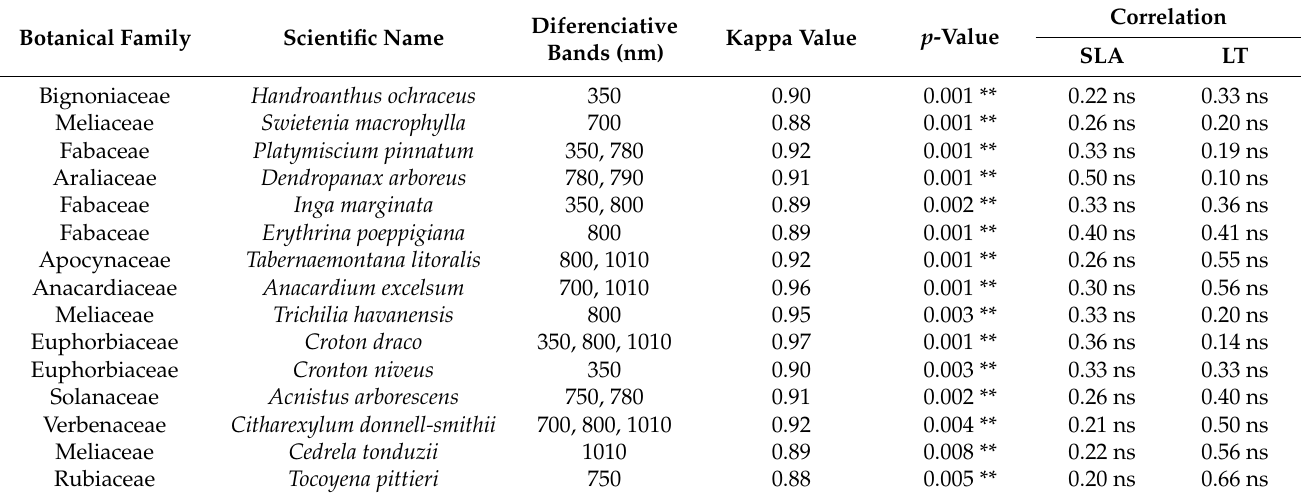
Table 1. Differentiating bands of spatial reflectance, average kappa value, and Pearson correlation values of the bands with the SLA (specific leaf area) and LT (leaf thickness) for 15 tropical tree species (ns: no significative, * p > 0.05 and ** p >